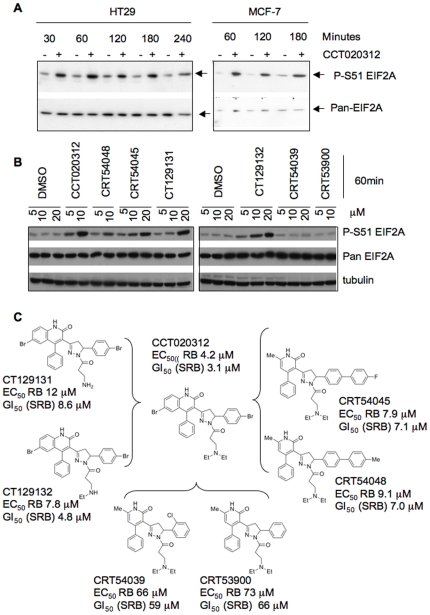
EIF2A phosphorylation in CCT020312-treated cells.
A) Detection of EIF2A phosphorylation following CCT020312 treatment. HT29 human colon cancer and MCF-7 human breast cancer cells were treated with 10 µM CCT020312 (+) or vehicle () for the times indicated. Lysates were prepared and immunoblot-analysis performed using antibodies to detect EIF2A and Ser51-phosphorylated EIF2A (P-S51EIF2A) as indicated. B) Structure-activity relationships. Representatives from different chemical series were tested using HT29 cells for their respective ability to activate EIF2A phosphorylation. C) Analogue structures and potency of analogues for reducing P-S608-pRB and growth.